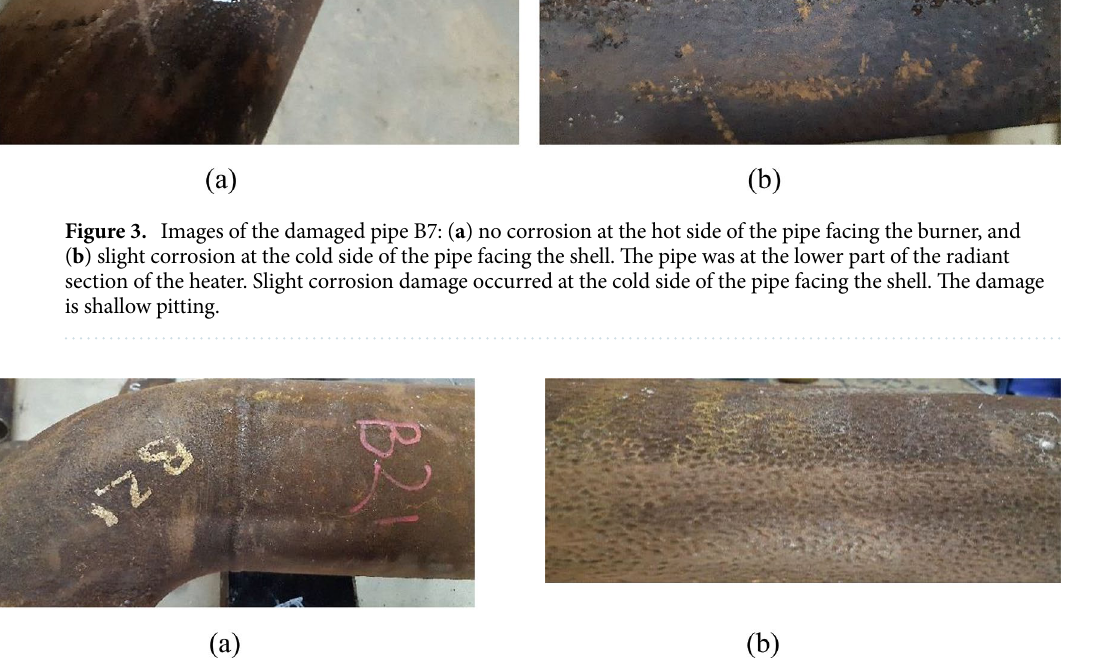
Figure 4. Images of the damaged pipe B21: ( a ) no corrosion at the hot side of the pipe facing the burner, and ( b ) slight corrosion at the cold side of the pipe facing the shell.